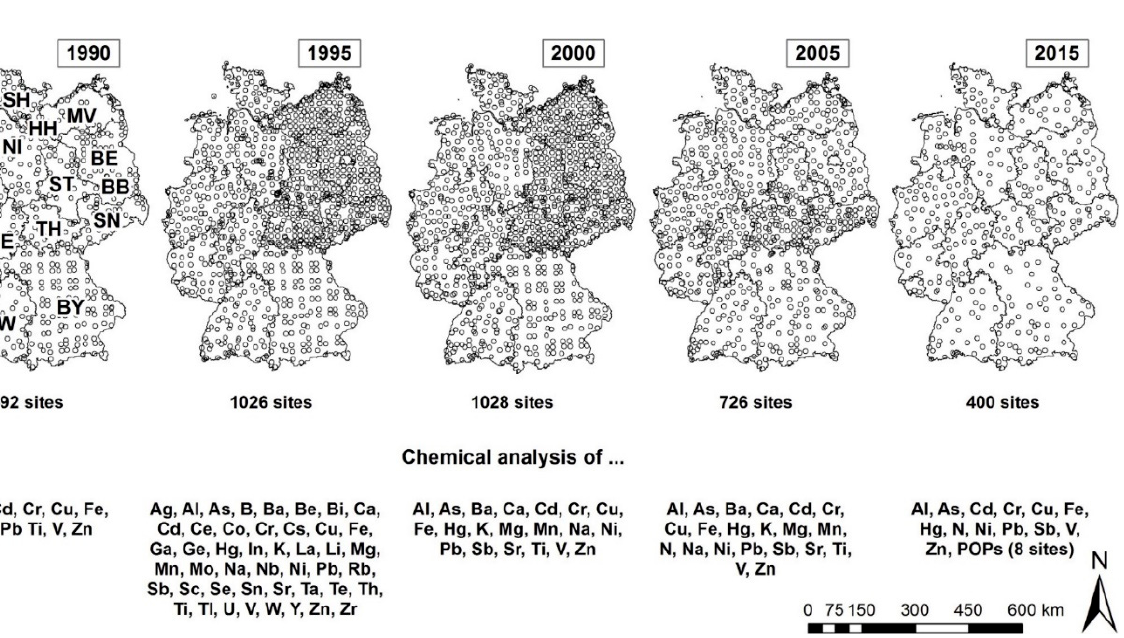
Figure 1. Sampling sites and elements regarding the German Moss Surveys 1990, 1995, 2000, 2005, and 2015. SH = Schleswig-Holstein; MV = Mecklenburg-West Pomerania; HH = Hamburg; NI = Lower Saxony; BE = Berlin; ST = Saxony-Anhalt; BB = Brandenburg; NW = North Rhine-Westphalia; SN = Saxony; TH = Thuringia; HE = Hesse; RP = Rhineland Palatinate; SL = Saarland; BY = Bavaria; BW = Baden-Wuerttemberg.